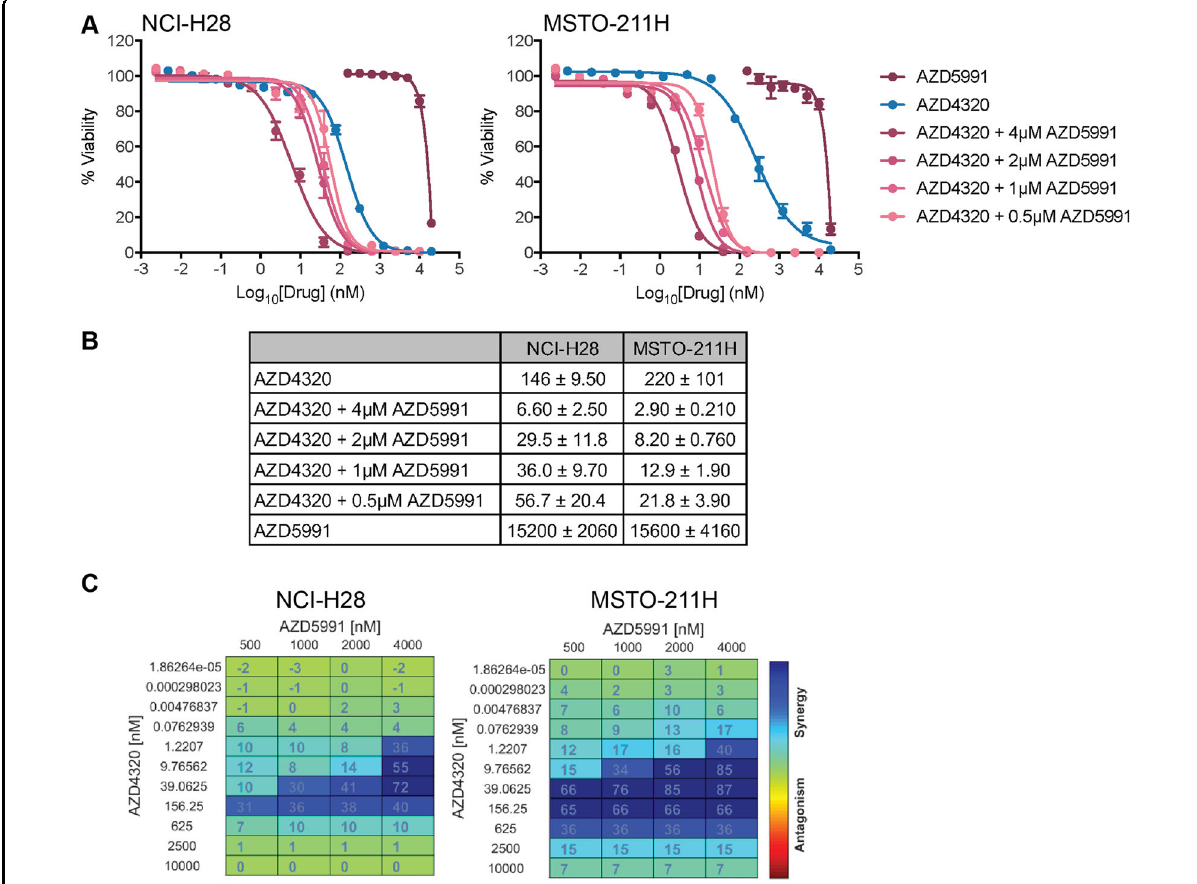
Fig. 1 AZD4320 inhibits MPM cell viability in vitro. A AZD4320 alone inhibits MPM cell line viability, and this effect is enhanced by co-treatment with AZD5991. Cell viability was determined using CellTiter-Glo assays after 72 h treatment. Data represent mean ± SEM ( n = 3). B Summary of EC 50 values for treatments in A . C Synergy analysis of BH3-mimetic drug combinations was performed with Combene fi t software using the BLISS synergy model. Strong synergy was observed across a range of drug